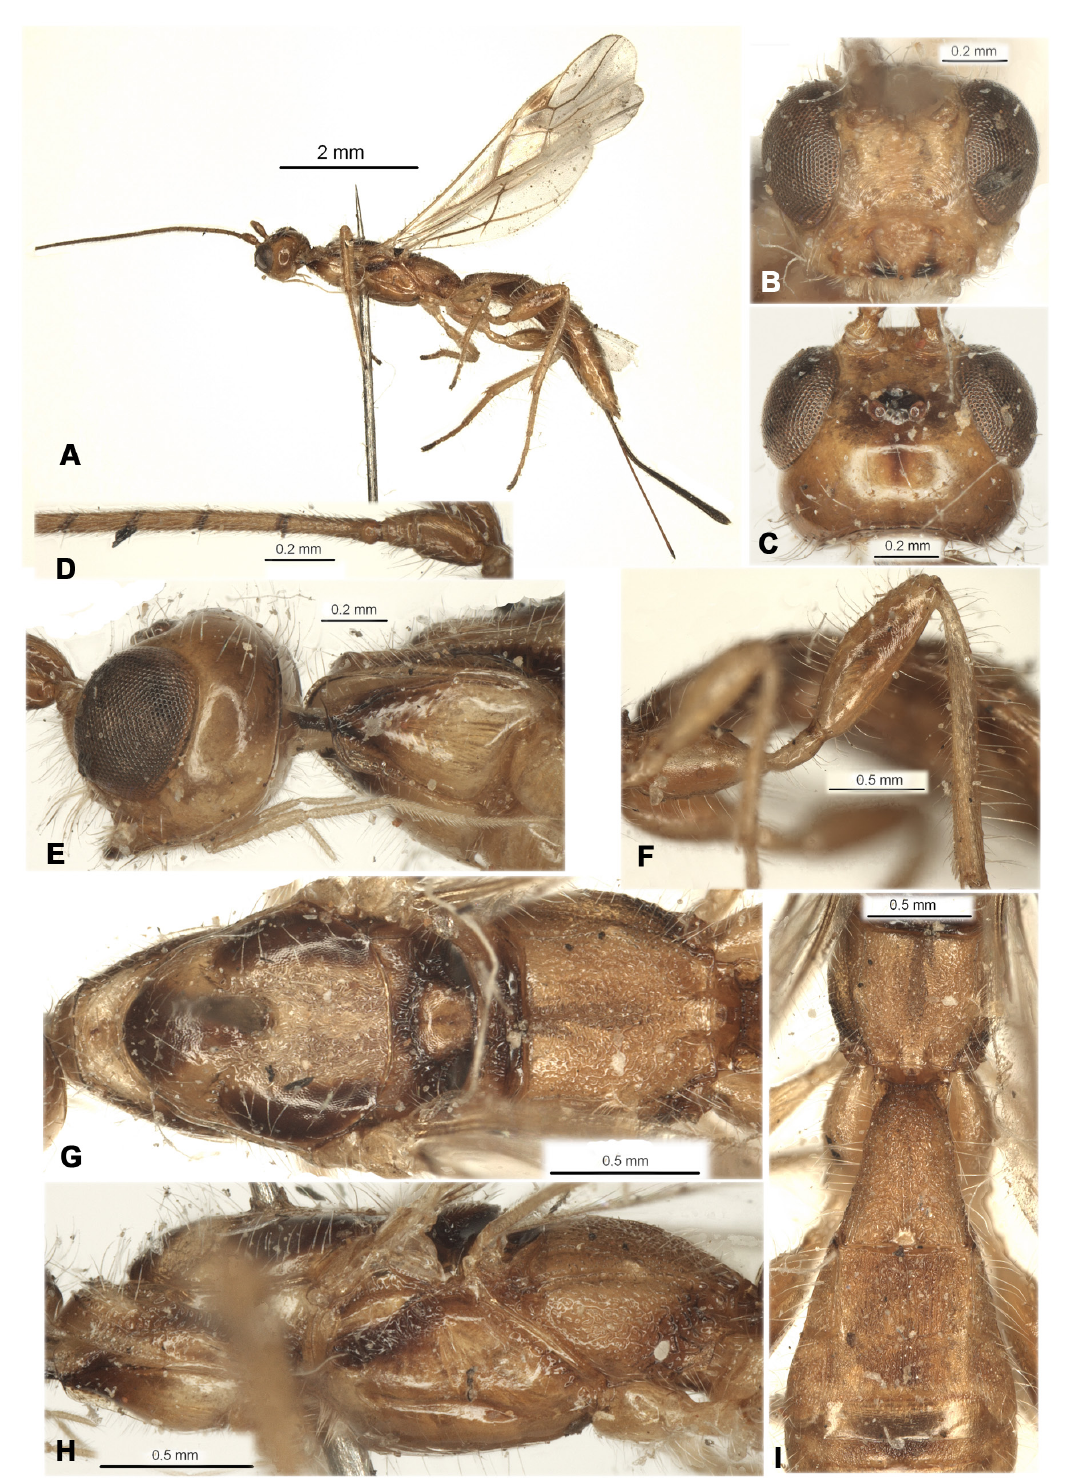
Fig. 9. Hemispathius pilosus (Granger, 1949) comb. nov., paralectotype, ♀ (MNHN). A . Habitus, lateral view. B . Head, front view. C . Head, dorsal view. D . Basal segments of antenna. E . Head, lateral view. F . Hind leg. G . Mesosoma, dorsal view. H . Mesosoma, lateral view. I . Propodeum and three basal tergites of metasoma, dorsal